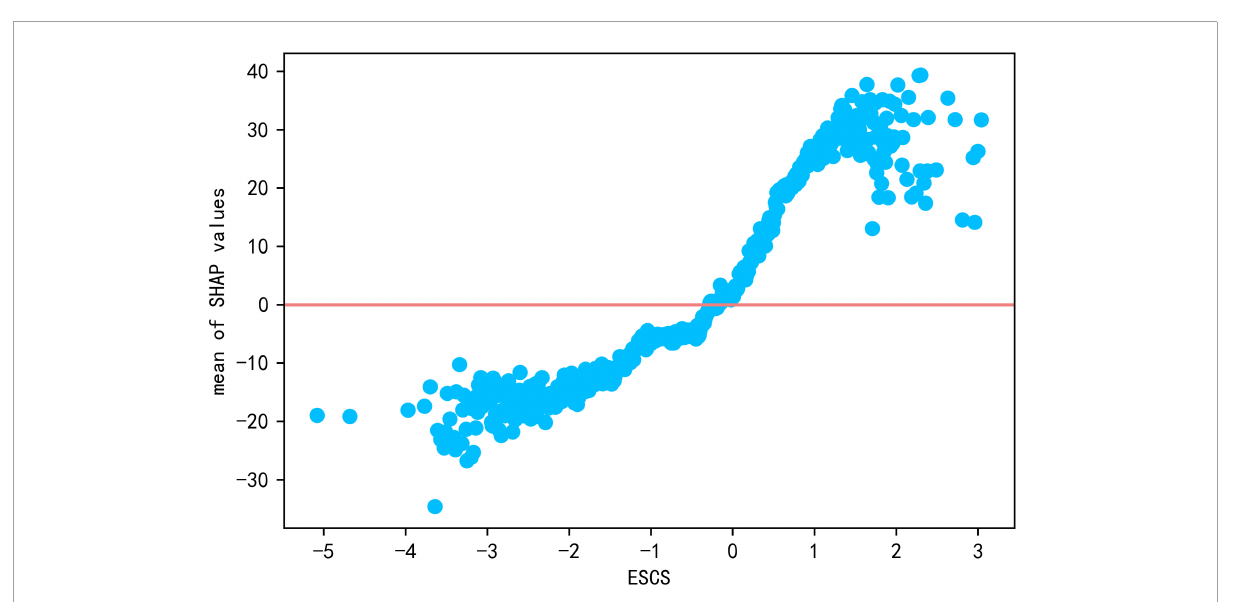
FIGURE5 The scatter plot of ESCS and Shap